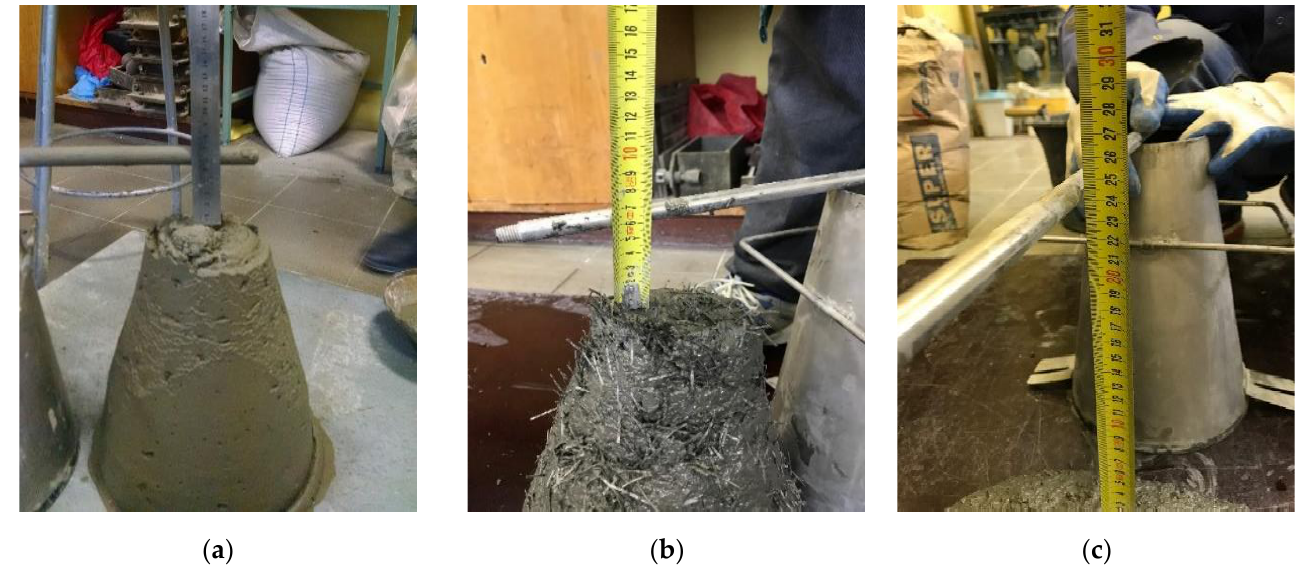
Figure 3. Slump cone test: ( a ) Group CSf; ( b ) Group CPPfS; ( c ) Group CPPfD.